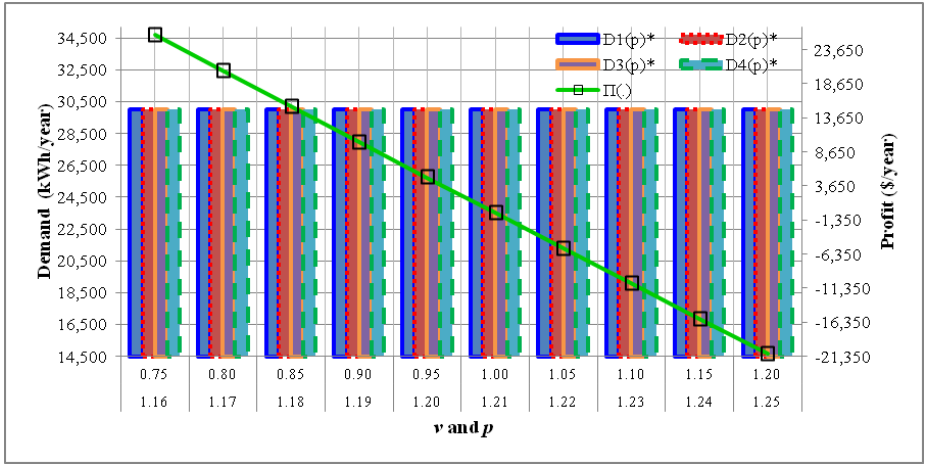
Figure 7. The Effect of Simultaneous Changes in the Power Supply Rate, Scaling Factor and Price Elasticity Coefficient on Profitand Demand.